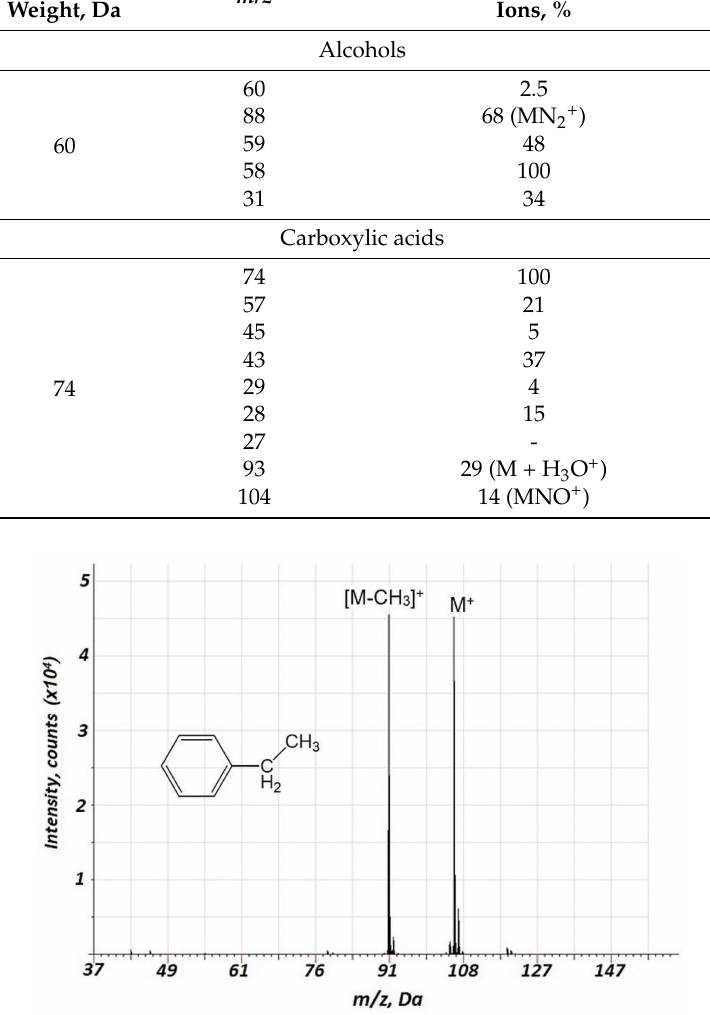
Figure 4. Background corrected mass spectrum range of ethylbenzene obtained using air glow discharge. Acquisition parameters were as follows: discharge pulse duration 1.2 µ s, discharge period 900 µ s, discharge pressure 153 Pa, repelling pulse delay 200 µ s; concentration of ethylbenzene of 20